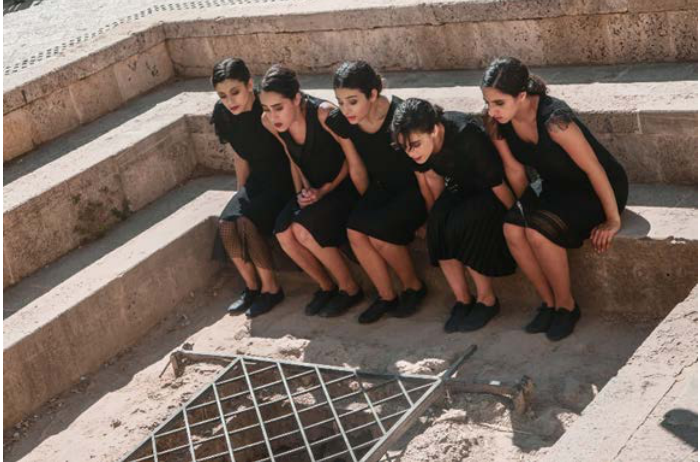
Figure 2. Echo : The well. Dancers: Rand Taha, Rima Naser Eeddin, Shahed Jabarin, Maria Alkeesh, Layal Mazzawi. (Photograph: Issa Freij).